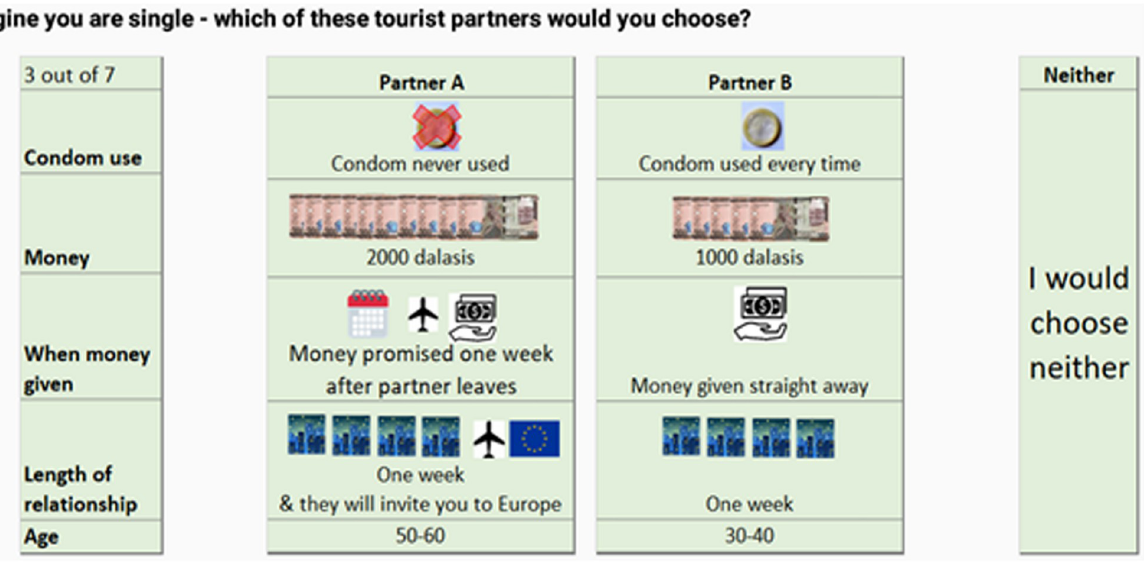
Fig 2. Example DCE